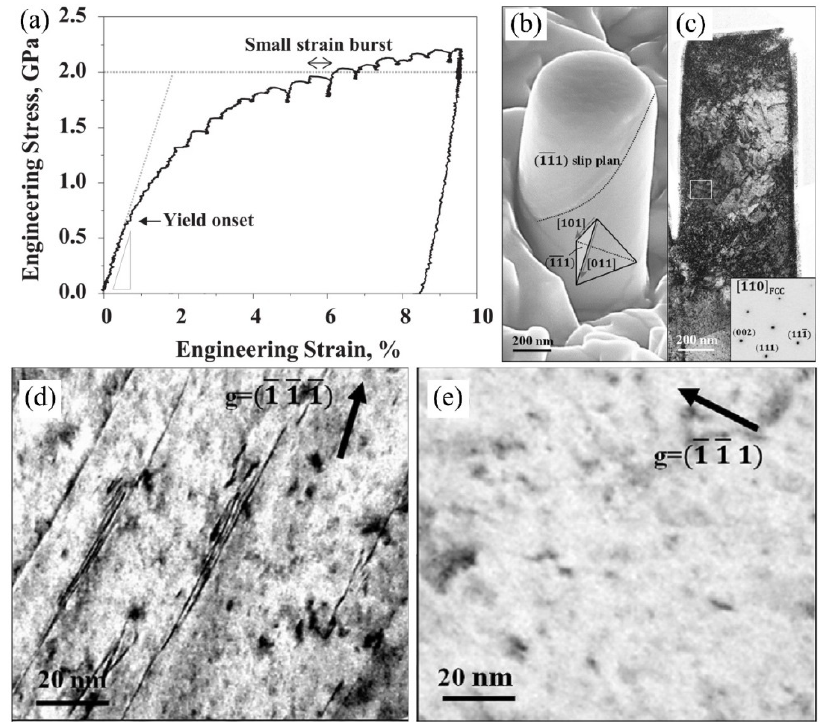
Figure 4. ( a ) Engineering stress–strain curve of austenite micro-pillar compressed along [111] crys- tal orientation. ( b ) The corresponding SEM micrograph of the austenite micro-pillar after the com- pression test. The inset in ( b ) is a tetrahedron indicating the orientation of the {111} slip plane. ( c ) TEM bright-field image displaying the formation of intensive dislocations in the pillar after com- pression test. ( d ) Magnified view of the rectangle in ( c ) showing the perfect dislocations along the (-1 -1 1) slip plane. € TEM BF image of the same region with different beam -direction [81]. Re- printed with permission from ref. [81]. Copyright 2017,